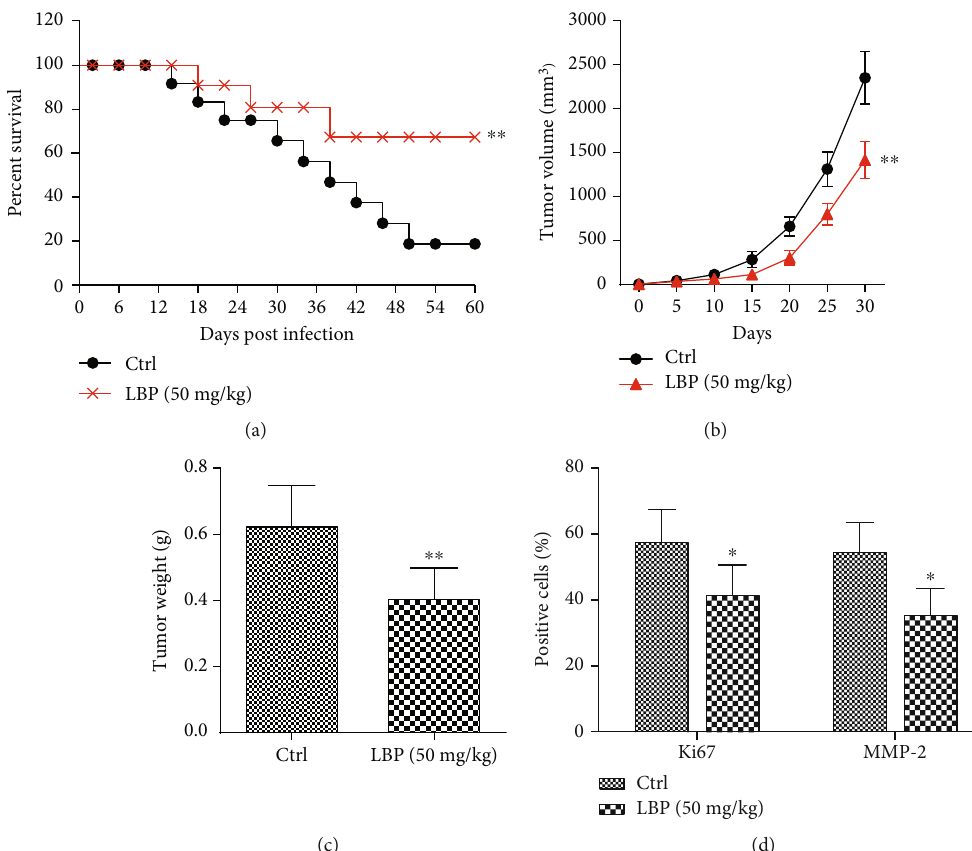
Figure 6: E ff ect of LBP on the growth of A431 cells in vivo ( n = 6 ). (a – c) E ff ects of LBP on the survival rate of transplanted tumor mice, weight, and volume of the tumor. (d) Ki67- and MMP-2-positive cells were detected by immunohistochemistry. Compared with the control group, ∗ P < 0 : 01 and ∗∗ P < 0 : 001